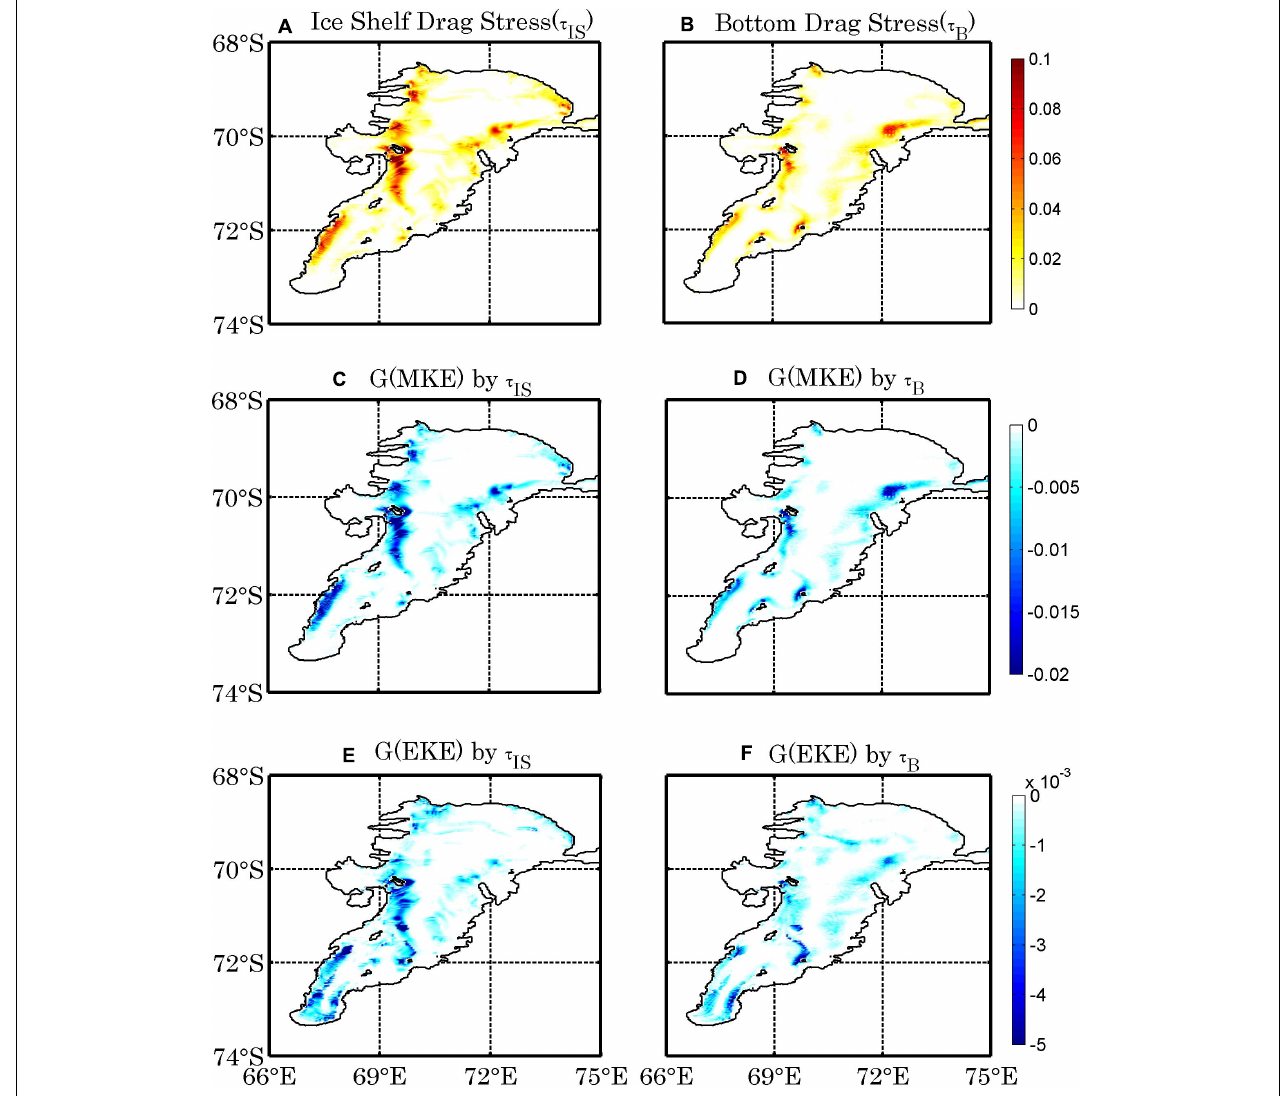
FIGURE 7 | The magnitudes of time-mean drag stress (N m − 2 ) (A) , and the energy dissipations induced by the time-mean (B) and time-varying (C) drag stress at the ice shelf-ocean interface (W m − 2 ). (D–F) as in (A–C) , but for the bottom drag stress and the relevant